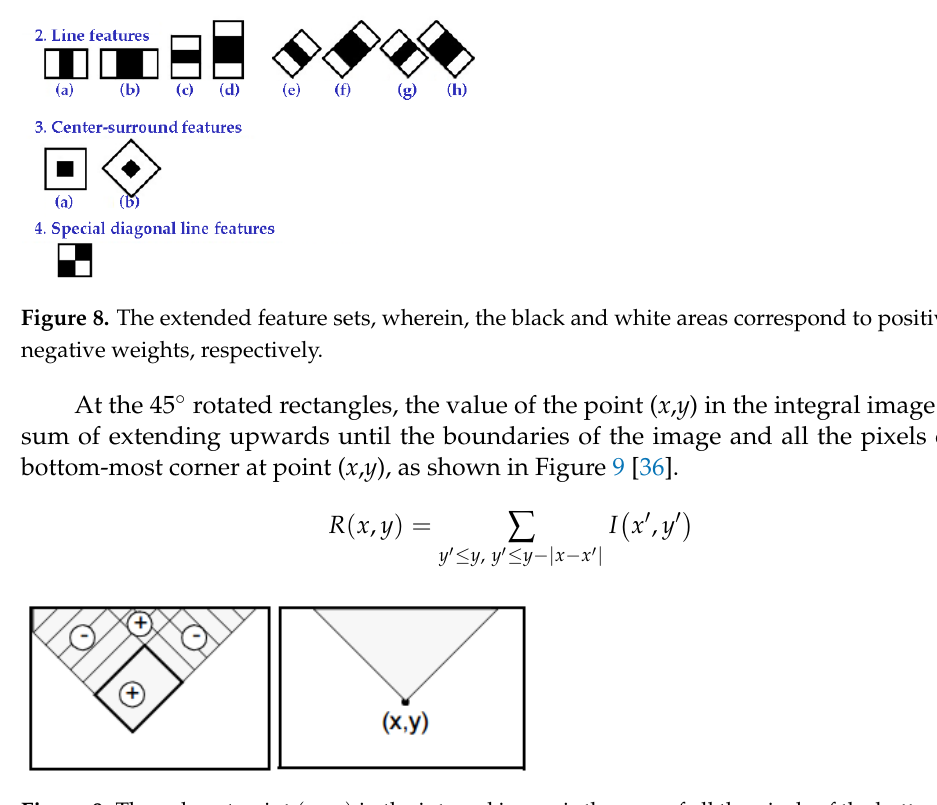
Figure 9. The value at point (𝑥, 𝑦) in the integral image is the sum of all the pixels of the bottom-most corner at point (𝑥, 𝑦) and extending upwards until the boundaries of the image.